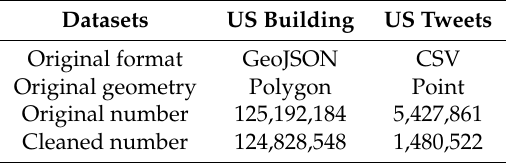
Table 1. Two large datasets used in this